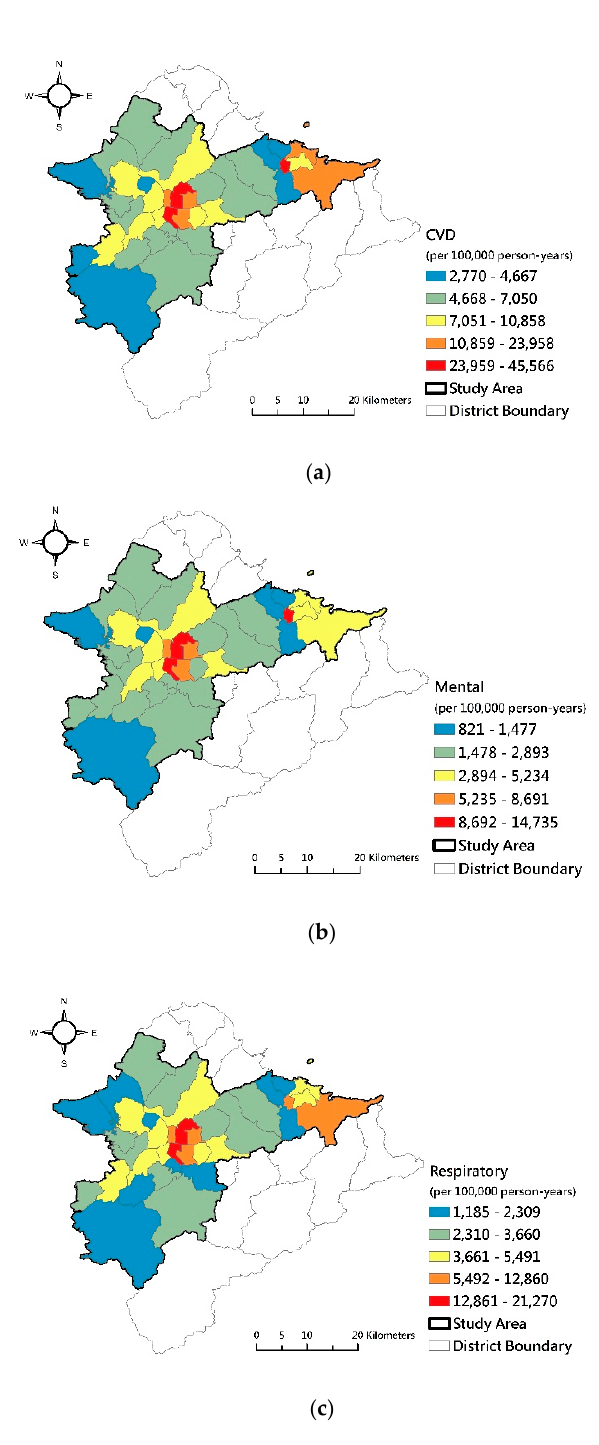
Figure 4. Levels of the morbidity of the three types of diseases. ( a ) Cardiovascular diseases; ( b ) Mental disorders; ( c ) Respiratory diseases.